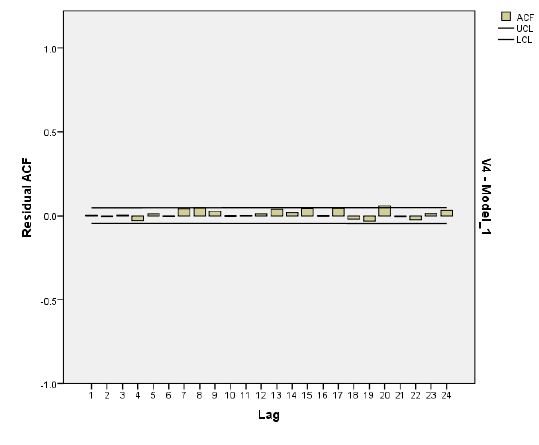
Figure 1. The differentiated auto-correlation function.